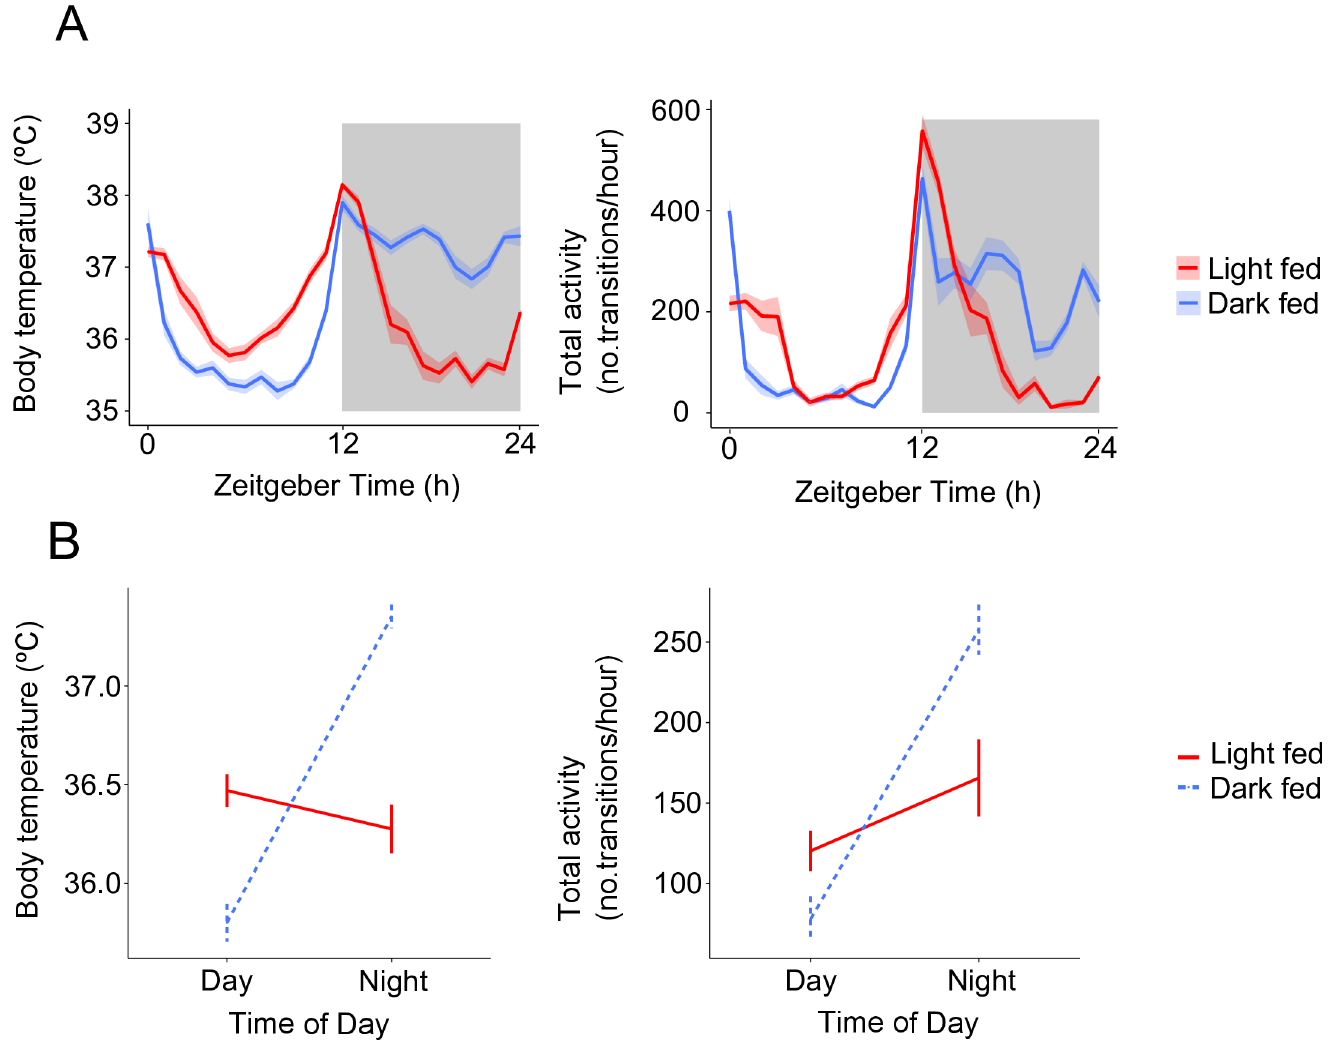
Fig 2. Feeding nocturnal mice in the day time disrupts rhythms in body temperature and locomotor activity. (A) Hourly mean ± SEM body temperature and locomotor activity (number of transitions per hour is the average number of movements a mouse makes in an hour, between antennae on the Home Cage Analysis system, see Materials and Methods) and (B) interaction between time-of-day and treatment group on body temperature and locomotor activity (calculating the mean temperature/activity across the day, ZT 0–12, and night, ZT 12–24, ± SEM) averaged from 48 hours of monitoring mice before infection. N = 5 for each of the light fed (LF, red) and dark fed (DF, blue) groups. Light and dark bars indicate lights on and lights off (lights on: ZT 0/24, lights off: ZT 12).